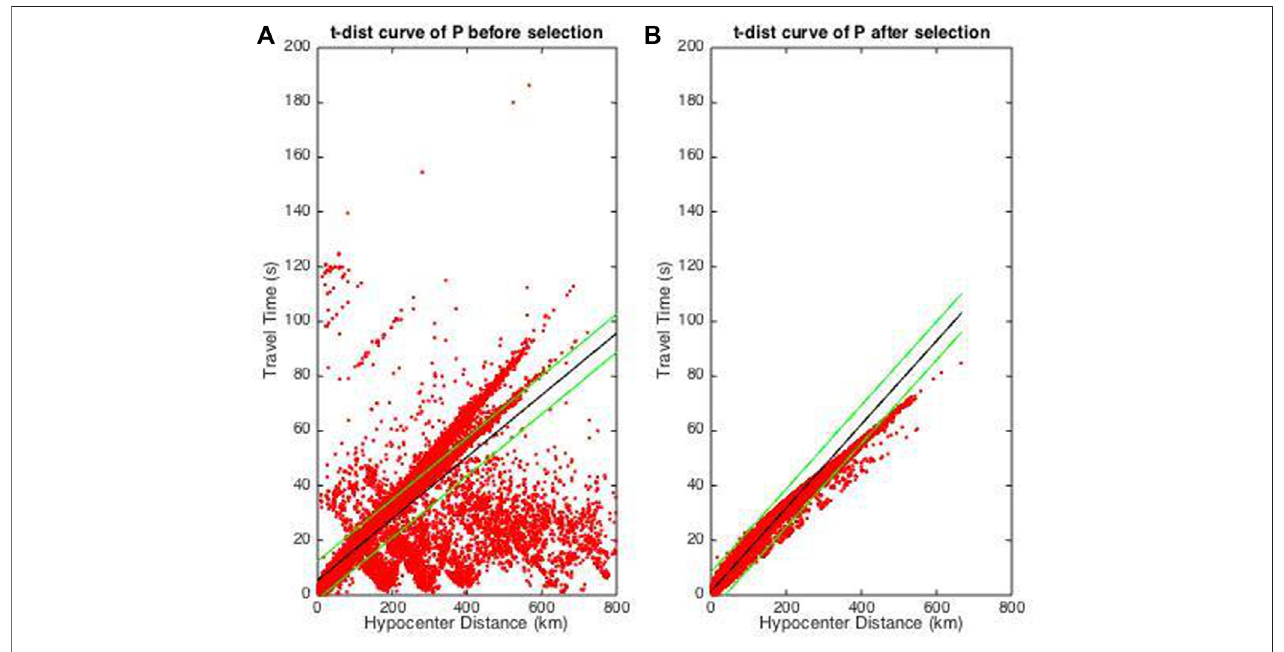
FIGURE 3 | Travel time curve before (A) and after selection (B) .